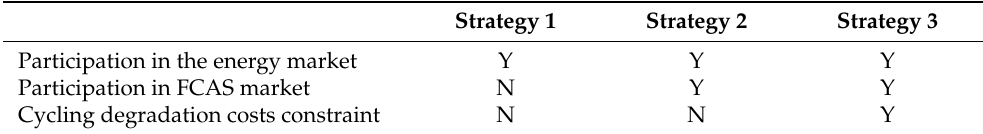
Table 4. BESS bidding